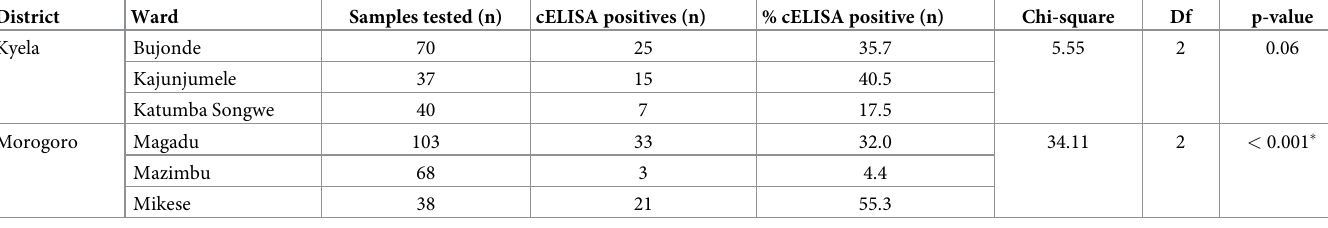
Table 2. Distribution of RVFV seroprevalence in different wards in Kyela and Morogoro districts, Tanzania. District